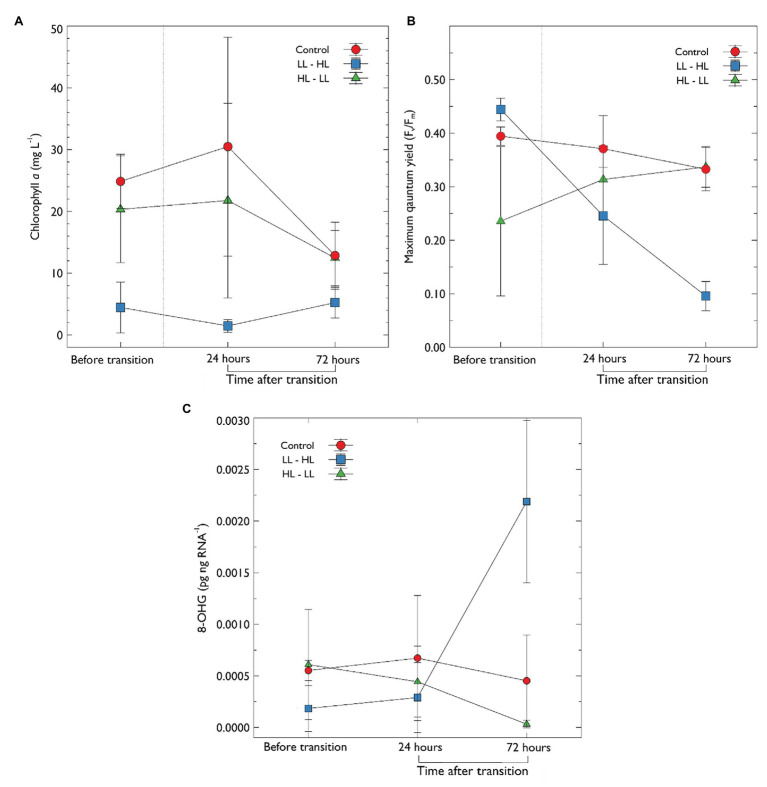

(A) Chlorophyll a concentration and (B) maximum quantum yield (Fv/Fm) of photosystem II and, (C) concentration of 8-OHG in algal extracts, 8-OHG is a marker for RNA oxidative damage. Sea-ice algal communities were acclimated to their respective snow treatment for 10 days before sampling. After 10 days, an initial sample was collected, denoted “before transition”; following this, the snow was transitioned as previously described (Table 1). Samples were then collected at 24 and 72 h after the transition. Error bars represent the standard deviation of the mean (n = 3).